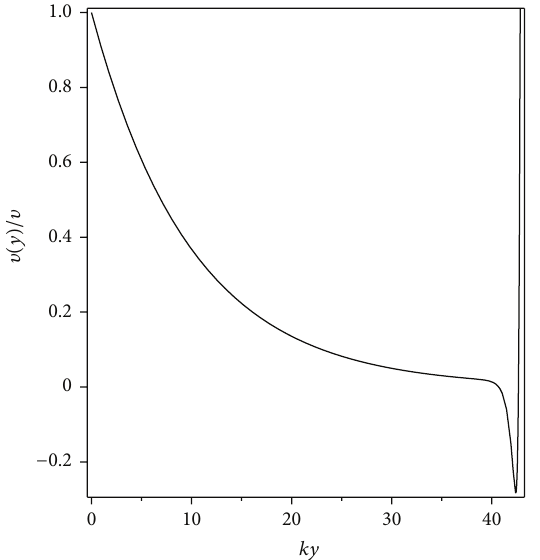
Figure2:ThedependenceofVEVprofileunder (𝐷, 𝐷) BCsforlarge positive brane cosmological constant with ℵ = 20 (dotted line), ℵ = 28 (dashed line), and ℵ = ∞ (solid line, i.e., RS case). We take the same values for other parameters as the ones in Figure